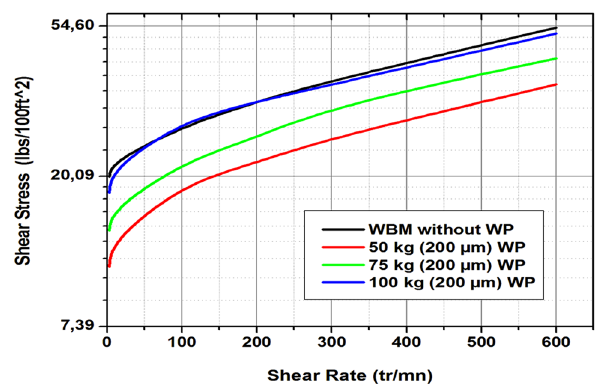
Fig. 7 XCD and PAC_R substituted by wood powder (WP at size = 200 µm) at different contents